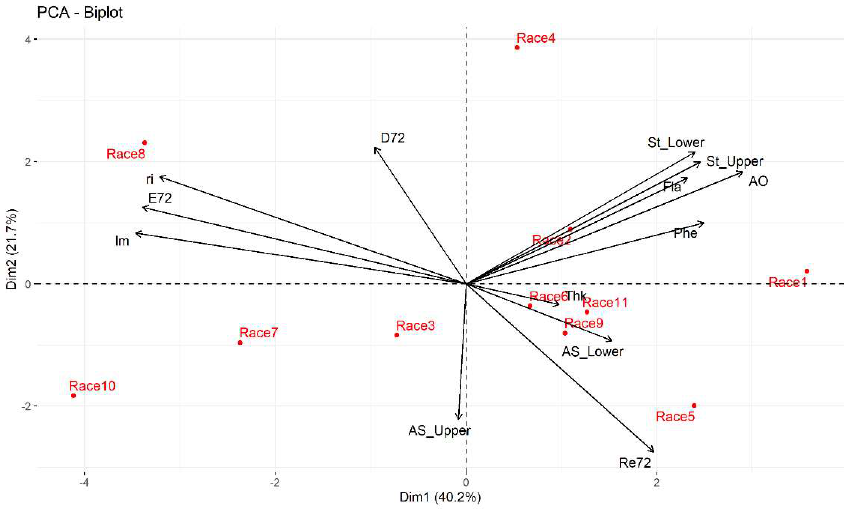
Figure 6. Biplot of the first two principal components of the thirteen variables and 11 maize races at 72 h under laboratory conditions. Race 1—Raton; Race 2—Olotillo; Race 3—Tuxpeño Norteño; Race 4—Bolita × Raton; Race 5—Elotes Occidentales × Tuxpeño; Race 6—Tabloncillo × Tuxpeño; Race 7—Chalqueño × Tuxpeño; Race 8—Celaya; Race 9—Vandeño; Race 10—Nal Tel × Raton; Race 11—Tuxpeño. E72—average number of eggs laid at 72 h; ri72—growth rate at 72 h; L72—average percentage of live mites at 72 h; Re72—average percentage of dead mites at 72 h; D72—average percentage of feeding damage at 72 h; Im—number of immature mites; St_Lower—average density of stomata on the underside of the leaf; St_Upper—average density of stomata on the upperside of the leaf; AS_Lower—area of stomata on the underside of the leaf; AS_Upper—area of stomata in the upperside of the leaf; Fla—total concentration of flavonoids; Phe—total concentration of phenols; AO—antioxidant activity.